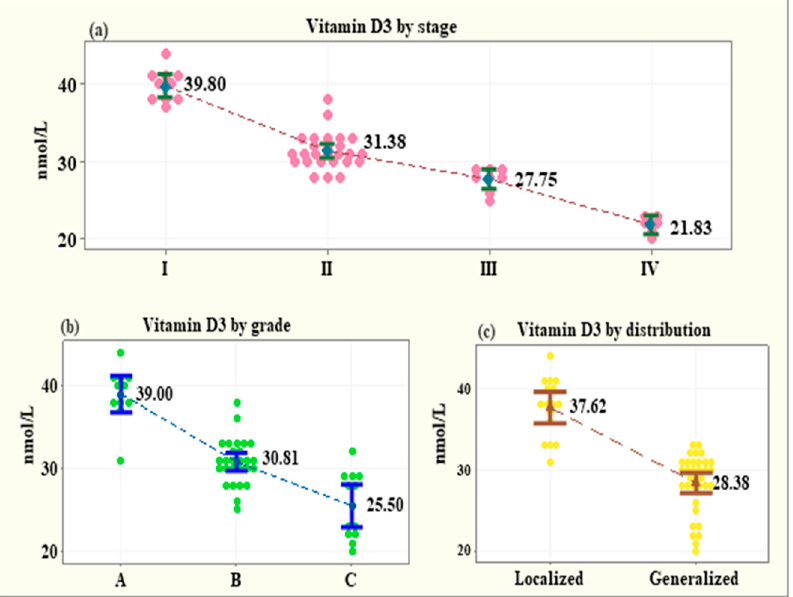
Figure 2. Vitamin D3 levels by the stage of periodontitis ( a ), the grade of periodontitis ( b ) and the distribution of periodontitis ( c ).